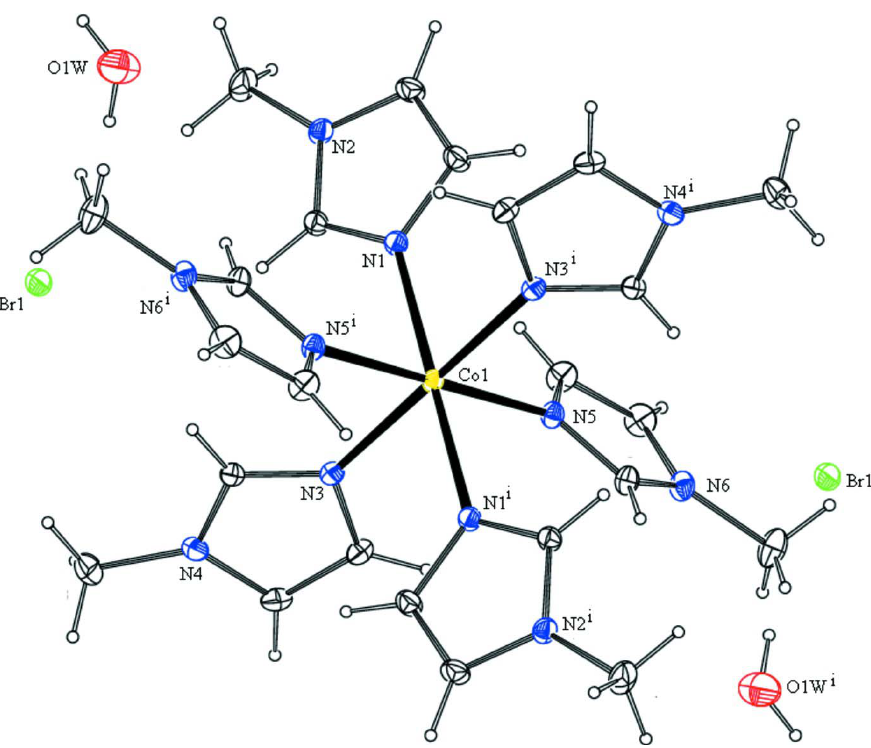
The molecular structure of the title molecule, with the atom-numbering scheme. Displacement ellipsoids are drawn at 30% probability level [symmetry code: (i) 1 - x, 2 - y, 1 -